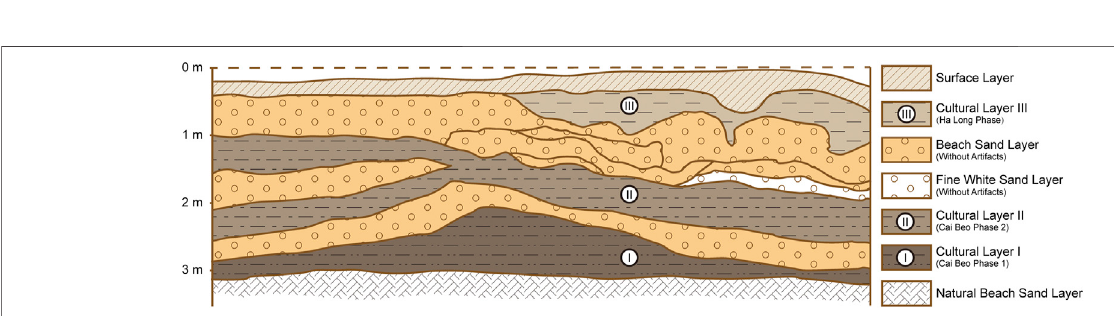
FIGURE 1 | Location of the Cai Beo site. The site is shown by a red triangle.